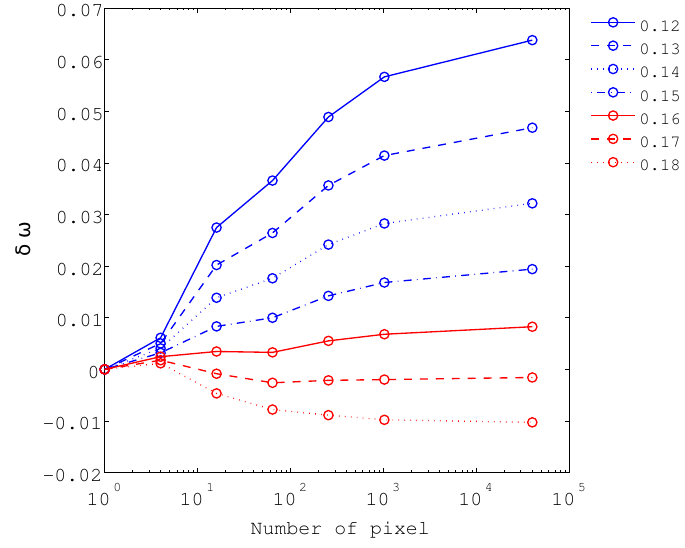
Figure 9. Scaling effects in the FVC, determined for various endmember spectra corresponding to the non-vegetation surface (Table 3) assumed in the